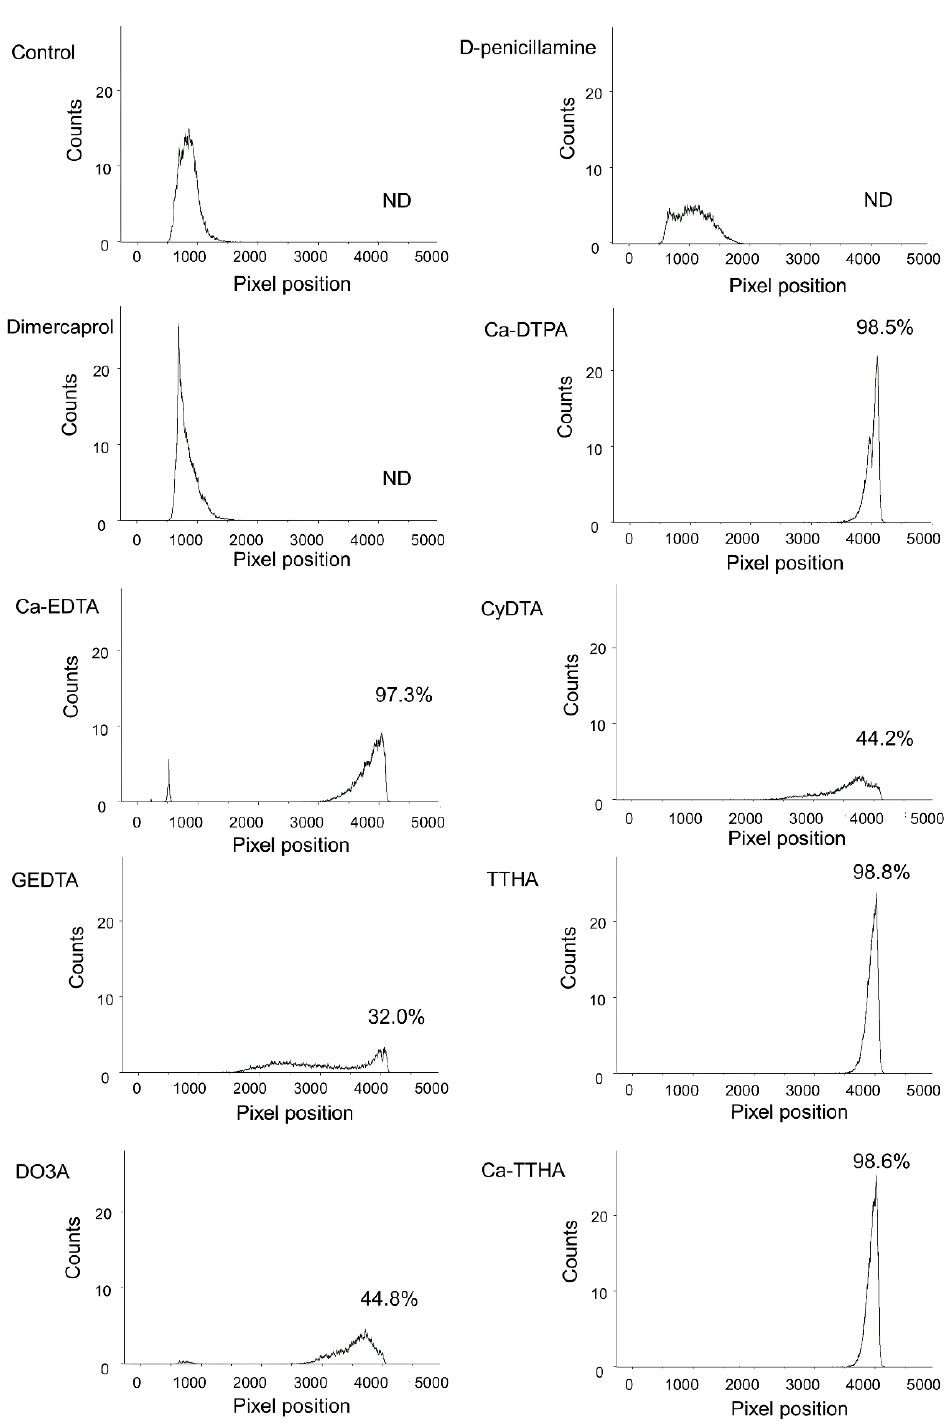
Figure 3. In vitro ability of the chelators to capture actinium-225 ( 225 Ac). Paper chromatography of free 225 Ac alone (control) and free 225 Ac with chelators. The percentages of radioactivity at the solvent front ( 225 Ac chelates) are shown for each chromatograph. ND = not detected.